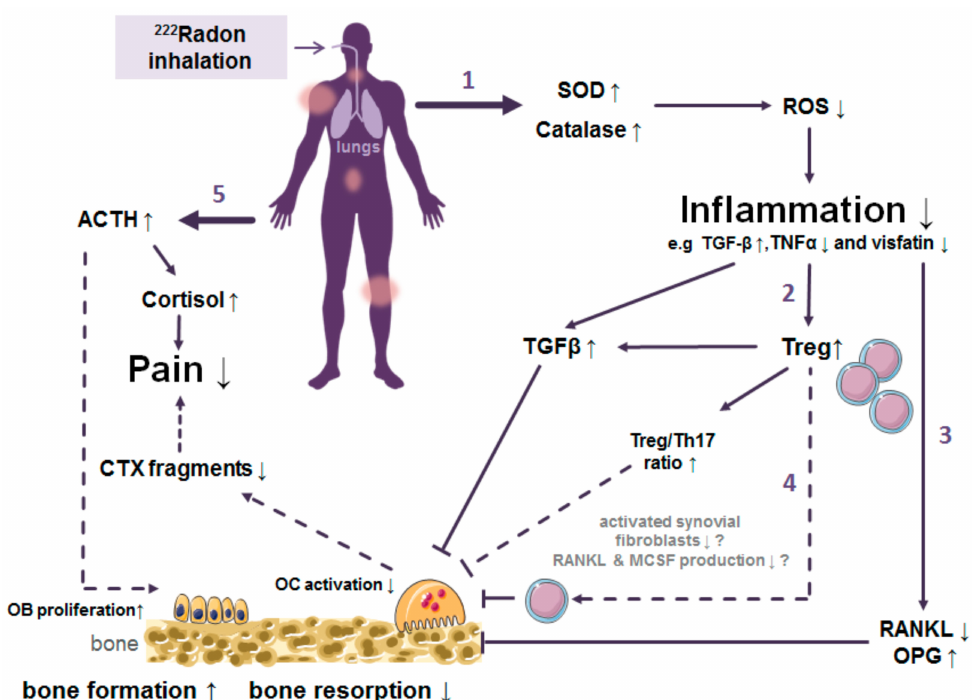
Figure 2. Proposed mechanism of action when radon is used to treat patients with a treatment for chronic musculoskeletal diseases (mostly ankylosing spondylitis, osteoarthritis or rheumatoid arthritis). Findings from in vitro or patient studies have been combined in this graph, where a solid line represents experimental findings ( – ) and a dashed line indicates a hypothetical relationship (- - - -). Please see the text for a more detailed discussion and the explanation of the proposed mechanisms (indicated by the numbered arrows). Abbreviations: ACTH Adrenocorticotropic hormone; CTX collagen fragments type I; OC osteoclasts; IL interleukin; RANKL receptor activator of nuclear factor- κ B ligand; OPG osteoprotegerin; ROS reactive oxygen species; SOD superoxide dismutase; TGF transforming growth factor; ↓ means decrease, while ↑ means increase. Illustrations based on pictures from Smart Servier Medical Art under the Creative Commons Attribution 3.0,